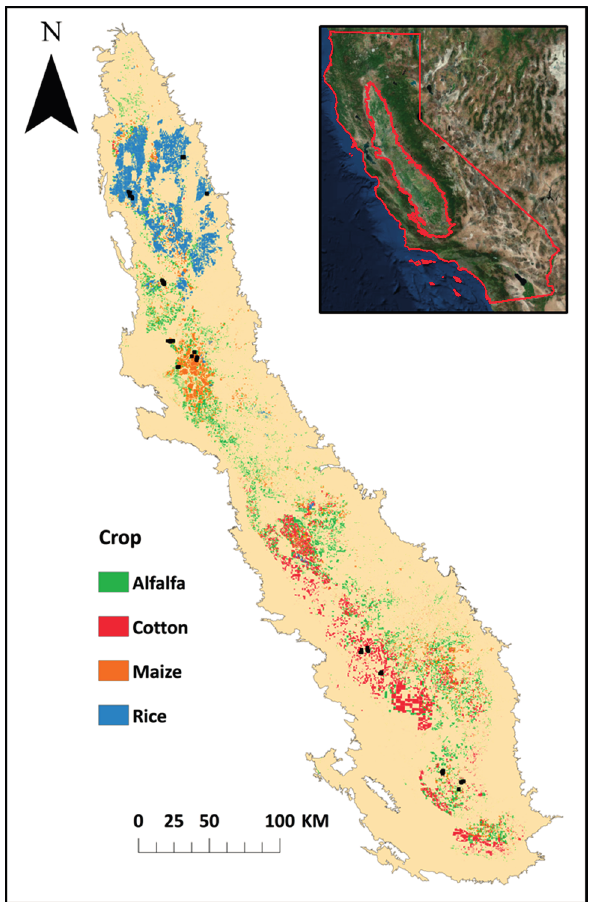
Figure 1. The spatial extent of non-spectroradiometric, spectroradiometric, and aboveground wet biomass (AWB) samples taken in the Central Valley of California in 2011 and